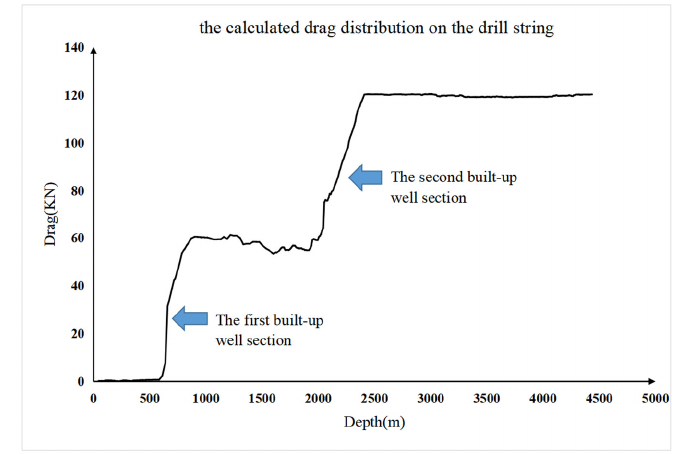
Figure 11. The calculated drag distribution on the drill string of well A.